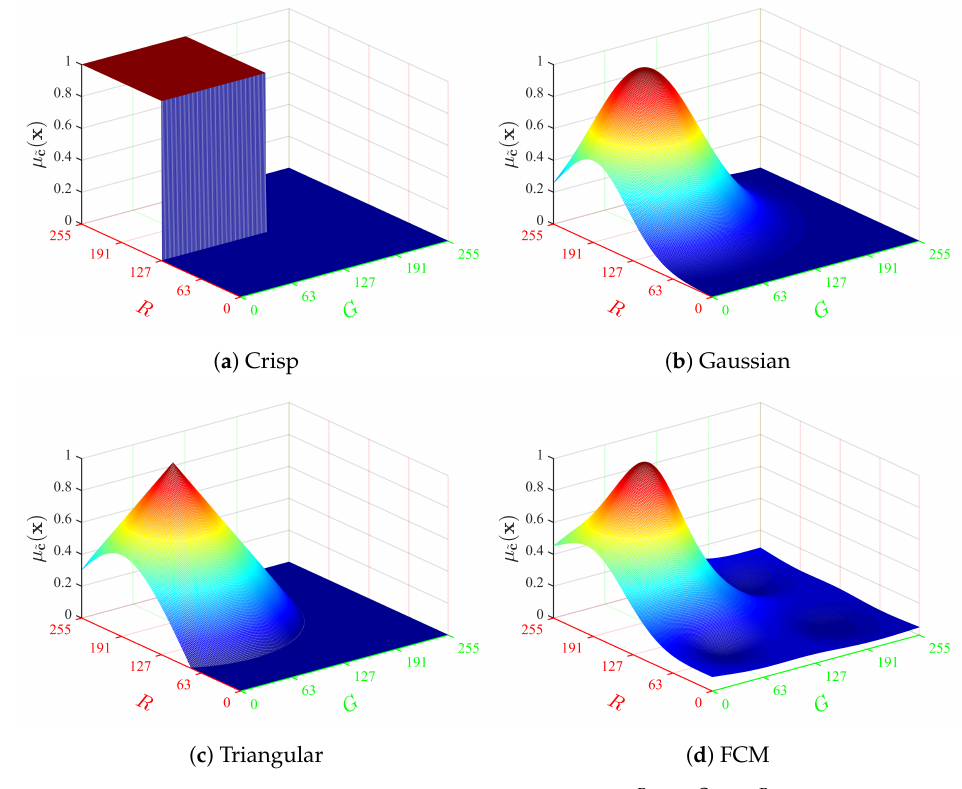
Figure 3. Membership functions µ ˜ c at c = ( 192,64,64 ) with C R = C G = C B =